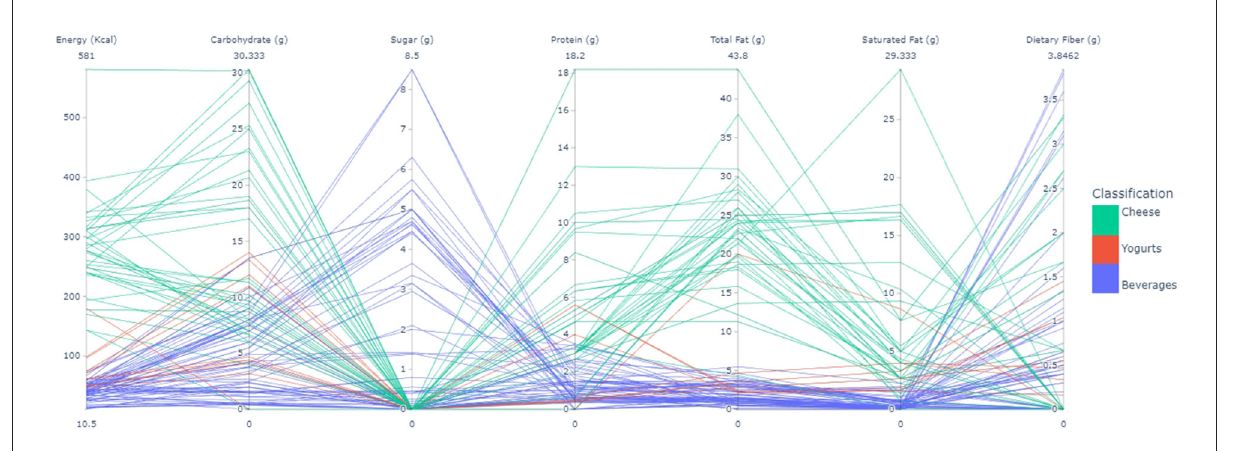
FIGURE1 Range of the nutritional values of the included milk